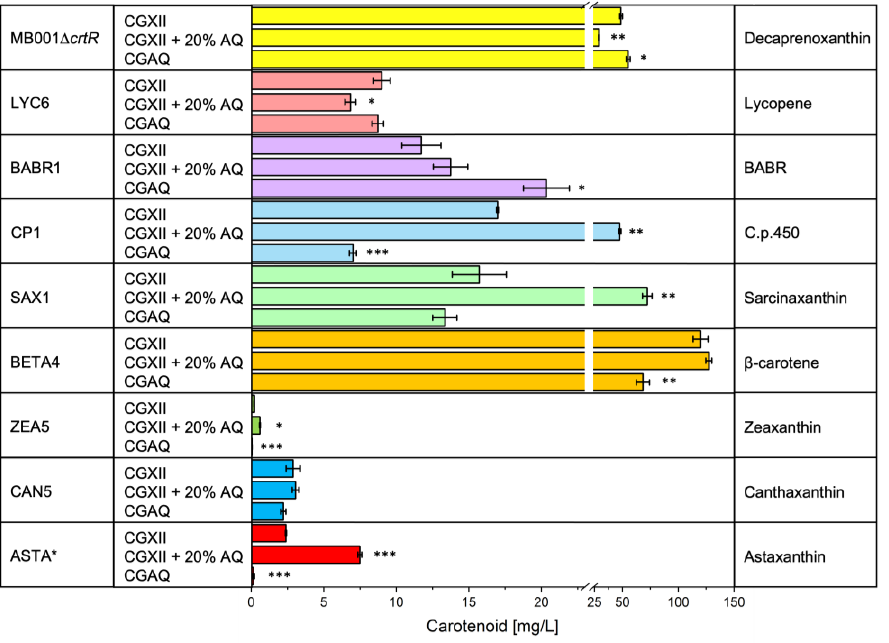
Figure 4. Carotenoid production of C. glutamicum strains in AQ supplemented media. Carotenoid production of C. glutamicum MB001∆ crtR (decaprenoxanthin), LYC6 (lycopene), CP1 (C.p.450), BABR1 (bisanhydrobacterioruberin), SAX1 (sarcinaxanthin), BETA4 ( β -carotene), ZEA5 (zeaxanthin), CAN5 (canthaxanthin), ASTA* (astaxanthin) grown on CGXII, CGXII supplemented with 20% ( v / v ) AQ, or the AQ derived medium CGAQ for 48 h. Values and error bars represent means and standard deviations of triplicate cultivations. Statistical significance in comparison to the cultivation of each strain in CGXII medium was assessed in Student ´ s t -test (*** p < 0.0001, ** p < 0.001, * p <